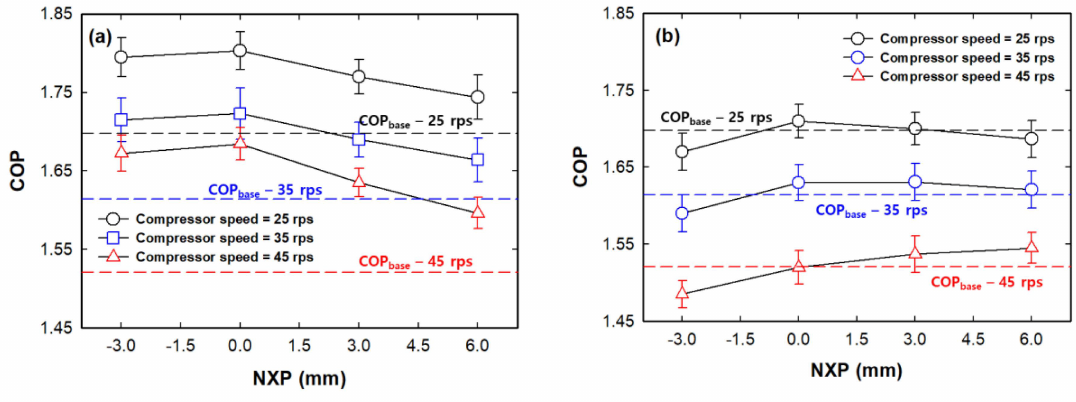
Figure 6. Variations in COP according to NXP for various compressor speeds at an ER of ( a ) 0.15 and ( b )